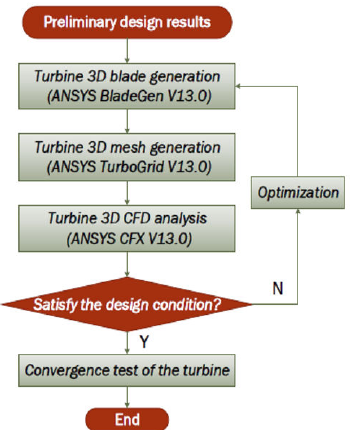
Figure 7. Flow chart of optimization for the radial outflow turbine.